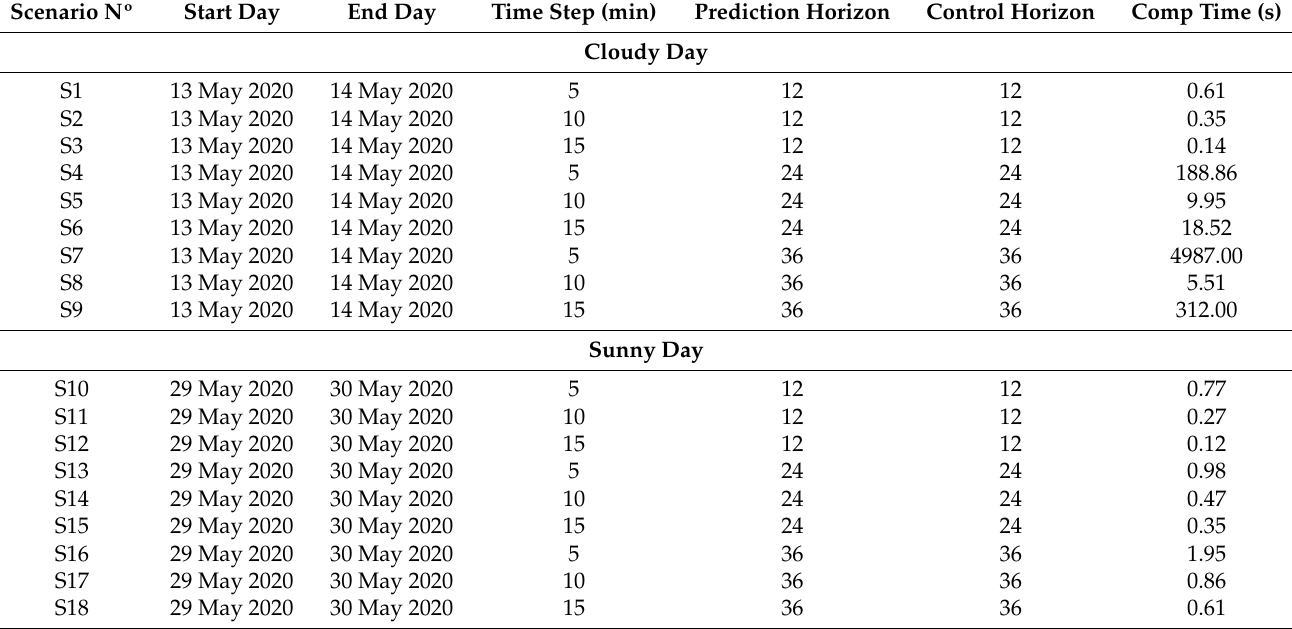
Table 2. Analysis 1. Scenario